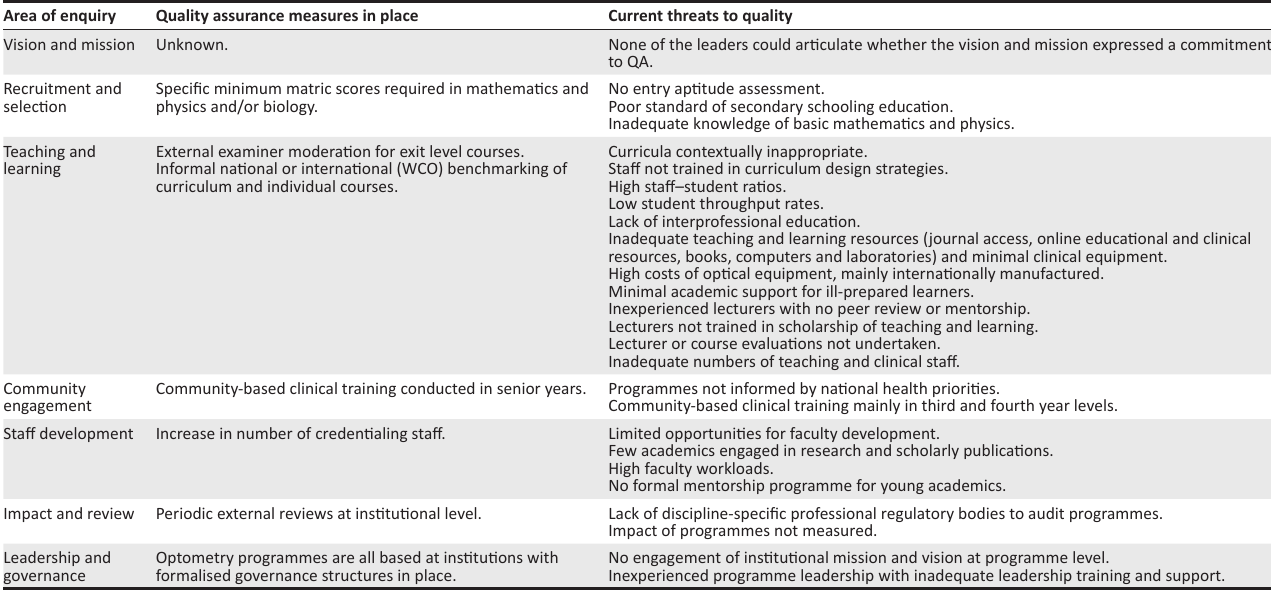
TABLE 2: Quality assurance protocols in place at discipline or institutional level and potential threats compromising quality as raised by the majority of interviewees. Area of enquiry